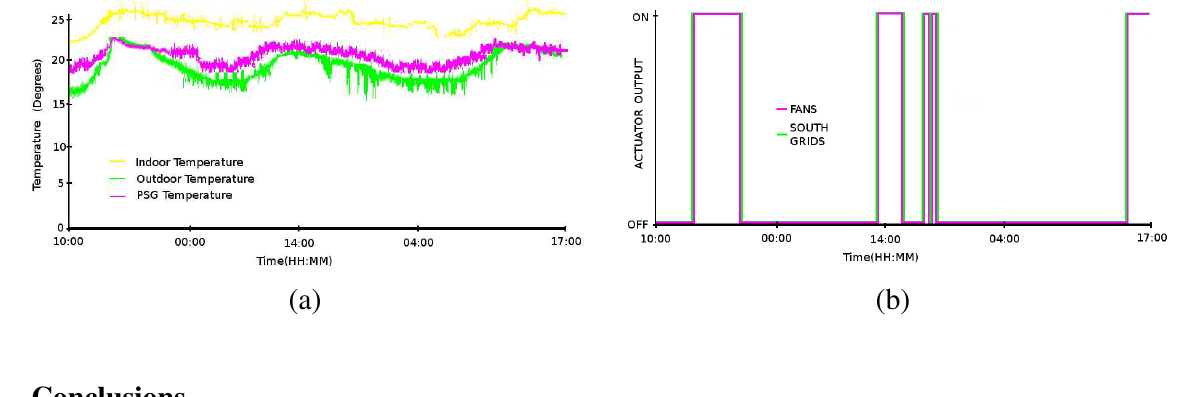
Figure 13. (a) Temperature and (b) actuator positions for the second experiment